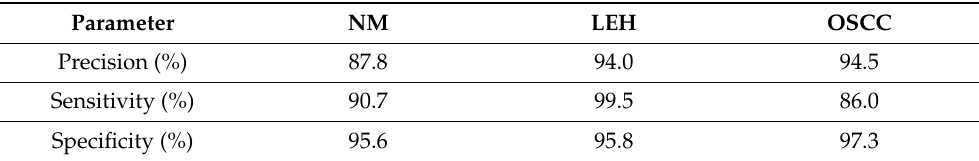
Figure 5. The performance comparison of using SVM as classifier and CNNs as feature extractor. Accuracy ( a ), sensitivity ( b ), precision ( c ), and specificity ( d ) of classification models using LeNet-5, VGG16, and ResNet18 as feature extractor, respectively. Table 2. The precision, sensitivity, and specificity of identifying NM, LEH, and OSCC using SVM combined with LeNet-5.